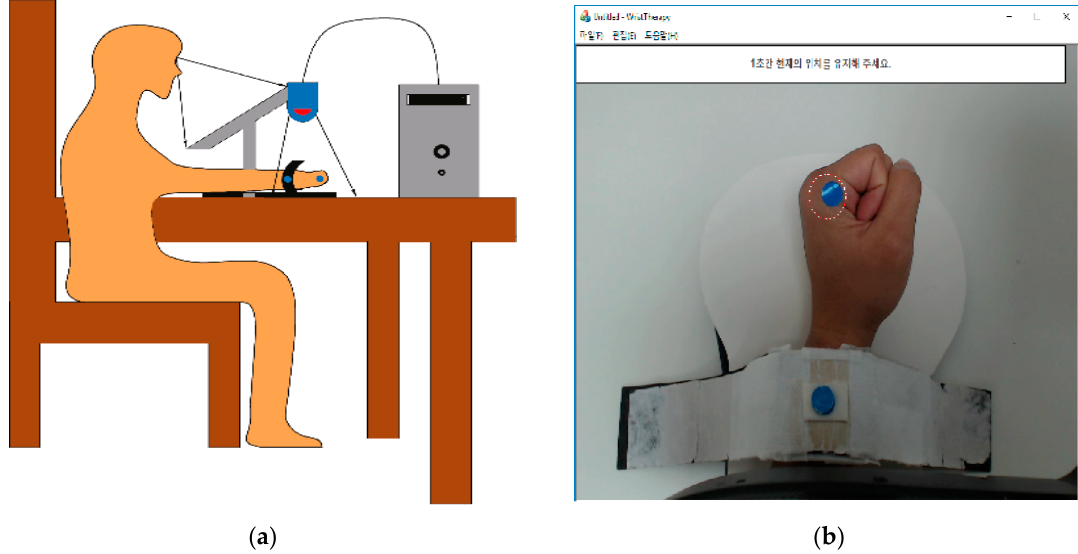
Figure 1. ( a ) A schematic view of the augmented reality (AR) system; ( b ) the users’ hands were placed on the arm holder of the table and their wrists were secured by the Velcro-strap; the two blue circle stickers were attached on the Velcro-strap and the users’